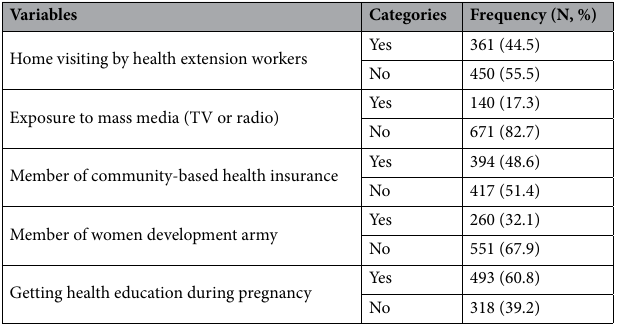
Table 2. Source of information about antenatal care visits and community participation related variables among delivered mothers in Northwest Ethiopia, 2020.